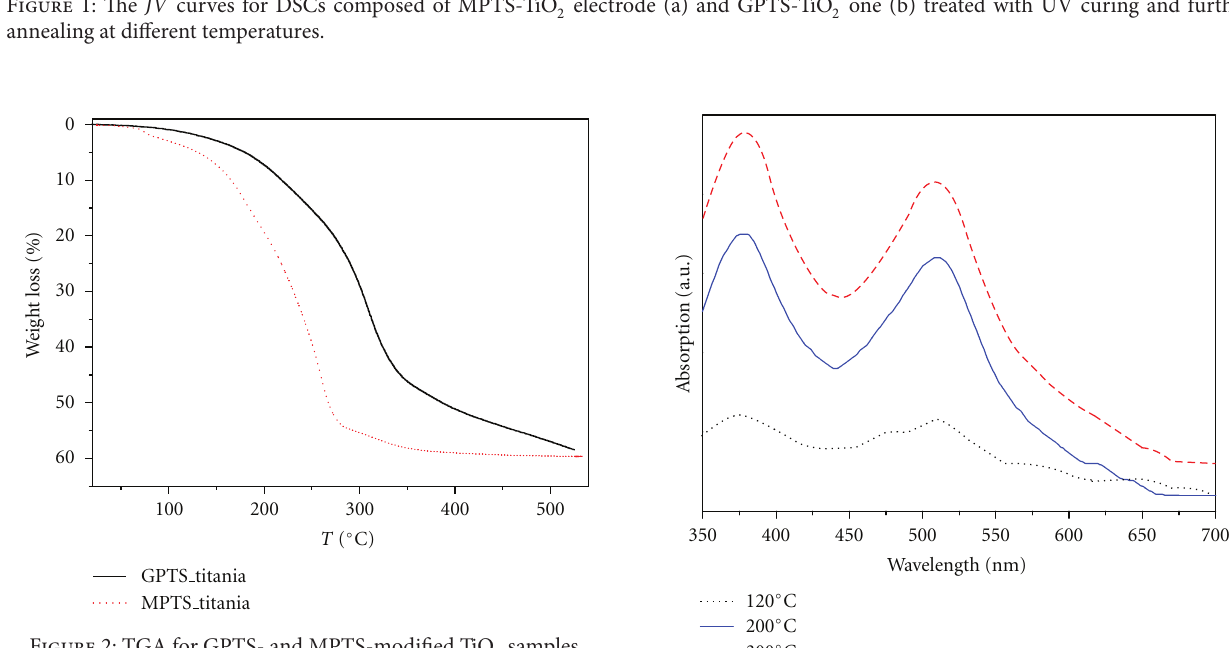
samples. 2 F 3: e UV-VIS absorption of the deattached dye from layers treated with UV curing and further annealing at MPTS/TiO different 2